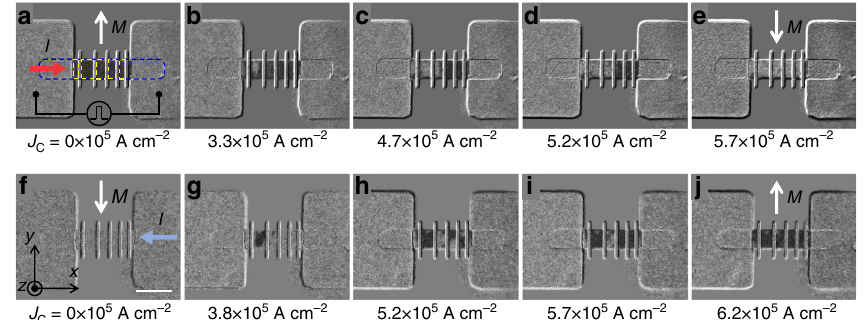
Fig. 5 MOKE images of SOT-driven magnetization switching in Bi 2 Se 3 /Py at zero magnetic fi eld and room temperature. a – e , MOKE images for SOT-driven magnetization switching by applying a pulsed dc current I along the + x -axis with increasing the current density J C in the Bi 2 Se 3 layer denoted underneath the corresponding image. The blue dashed rectangle in a represents the 12- μ m wide Bi 2 Se 3 /Py channel connected with two big contact pads. The yellow dashed boxes in a denote fi ve small Py rectangles magnetically isolated by Cu bars. f – j , MOKE images for SOT-driven magnetization switching for I along – x -axis. The dark (light) contrast shows the magnetization along + y ( − y )-axis. The direction of magnetization is also indicated by the white arrows in a , e , f , j . The white scale bar is 20